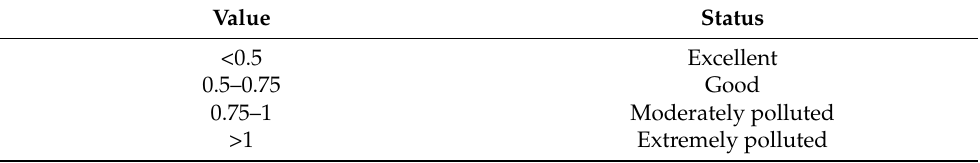
Table 2. Justification of water pollution level based on WPI scores